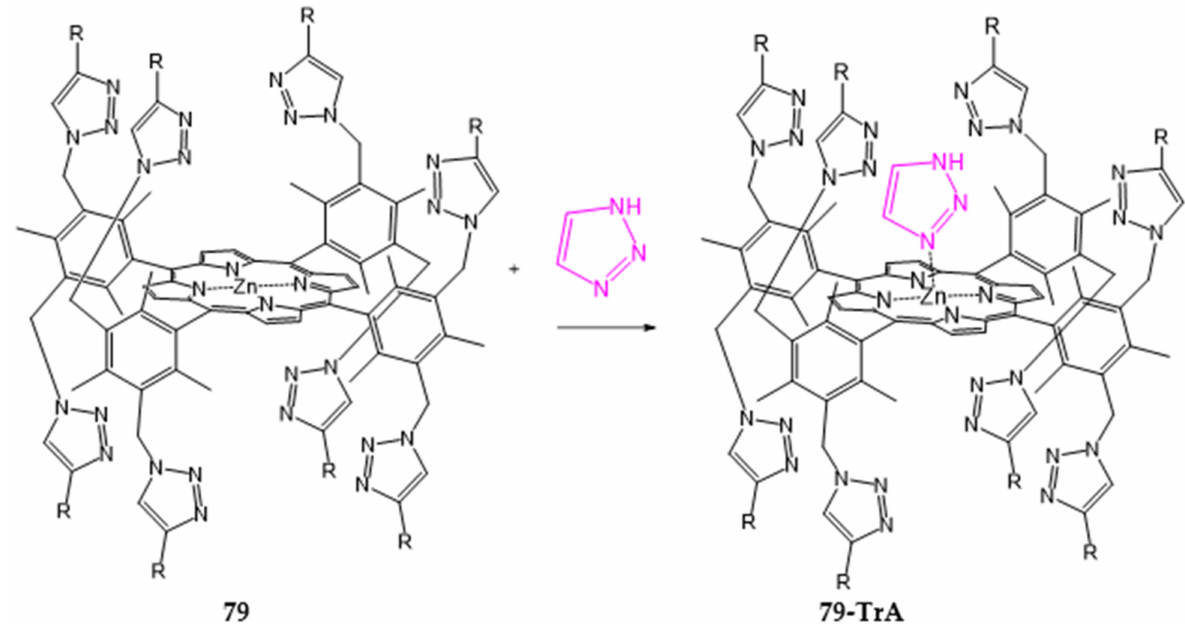
Scheme 26. Complexation of the receptor 79 with TrA.